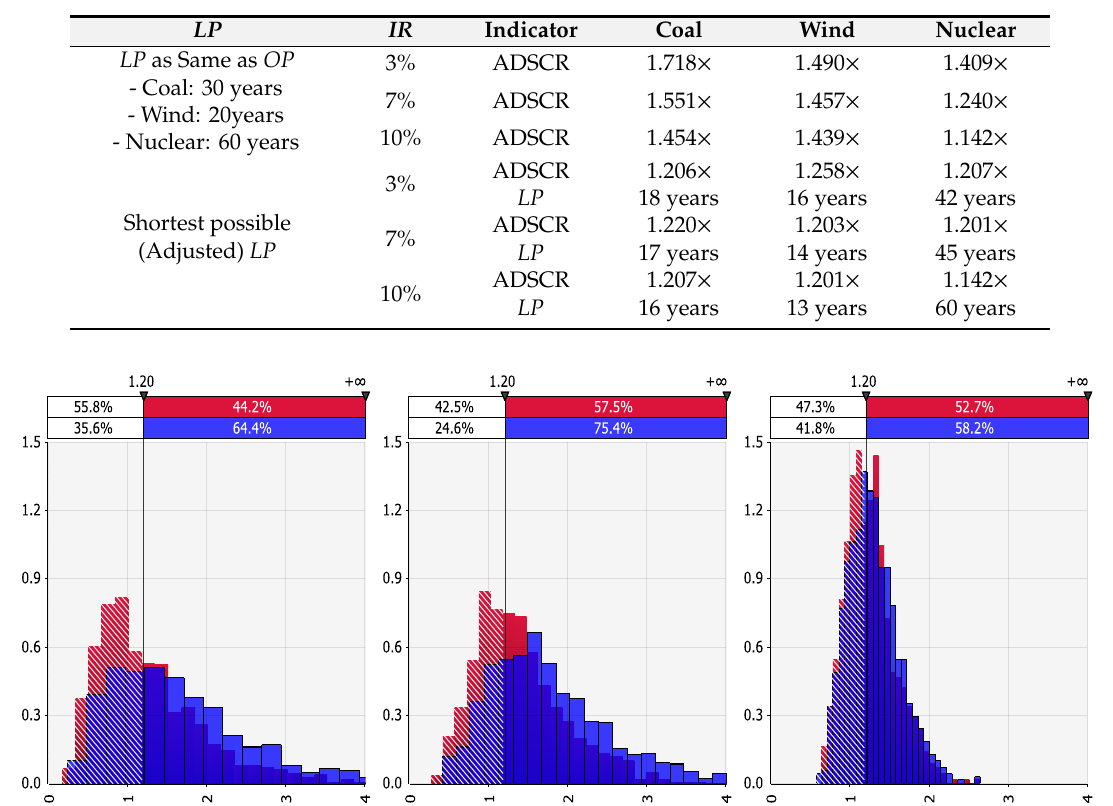
Figure 3. Equity IRR distributions of Coal, Wind, and Nuclear for original and adjusted LPs at 7% IR. For instance, the Equity IRR values during the original LP for each energy source are 12.58% for coal, 15.62% for wind, and 4.25% for nuclear at 7% IR . Relatively a large gap exists among energy sources because Equity IRR involves both the debt and interest concepts. Wind power has the highest